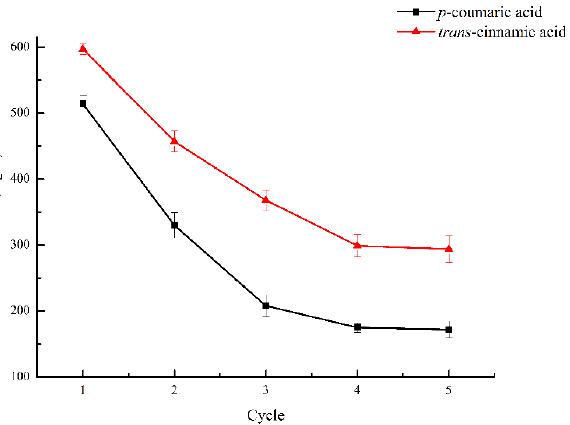
Figure 8. Batch reactions with repeatedly used E. coli BL21(DE3)/pETDuet-1-RgPAL cells at cell amounts of 10 g/L. amounts of 10